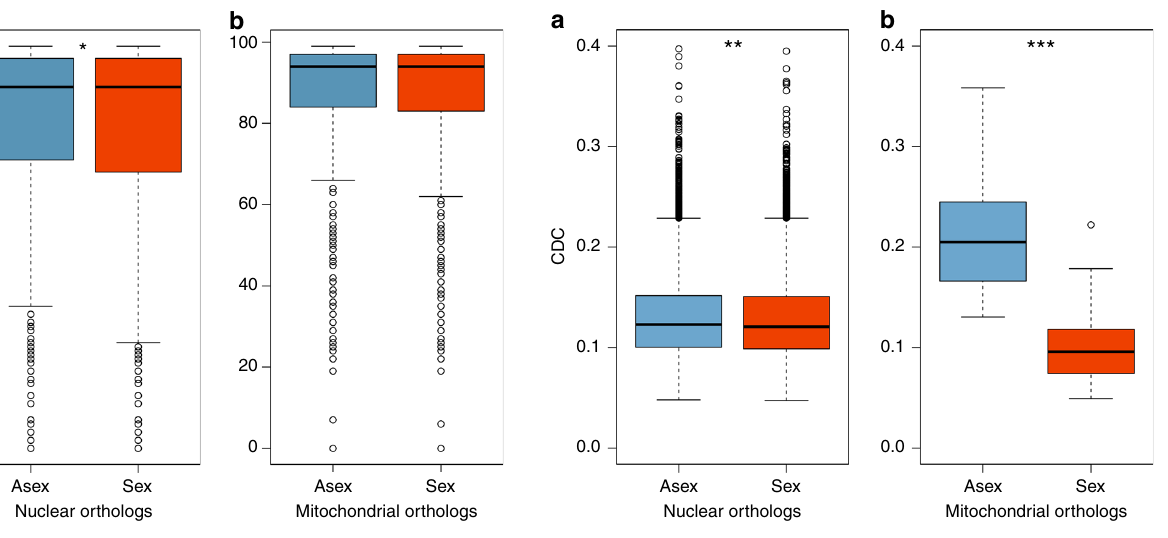
Table 1 Results of the branch-speci fi c d N /d S ratio analyses of ef1 α and hsp82 for 21 asexual and nine sexual oribatid mite species Model Free parameters ln L Likelihood ratio test